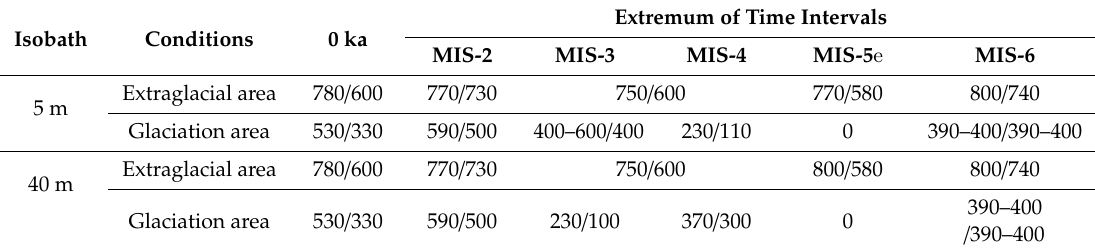
Table 1. Dynamics of the depth of the GHSZ lower boundary (numerator) and thickness (denominator) at the heat flux of 60 mW / m 2